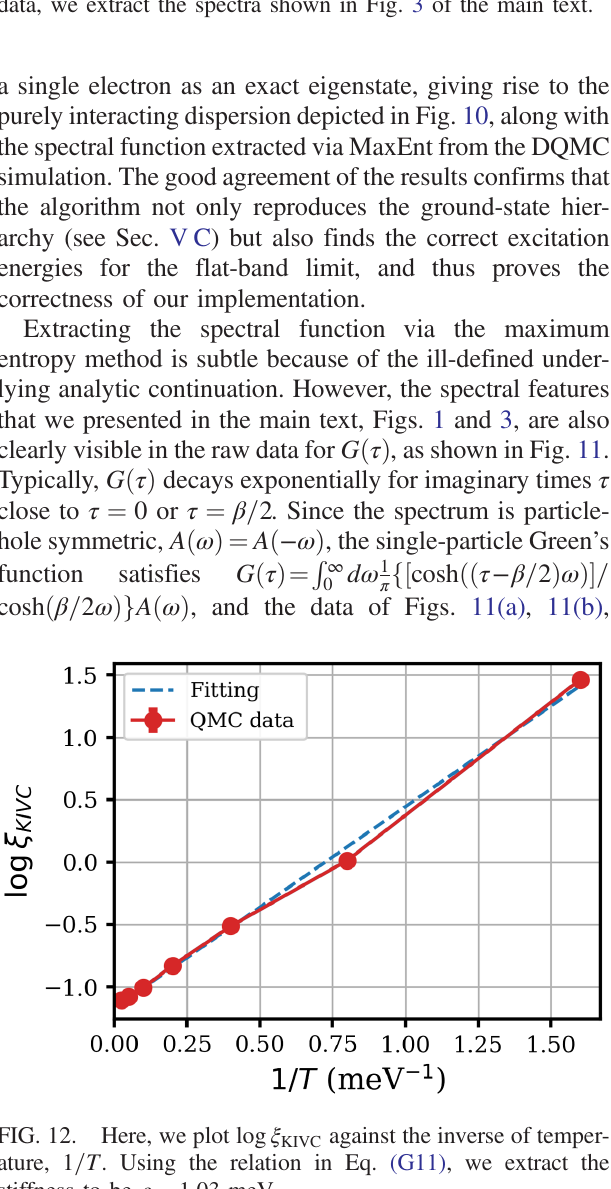
FIG. 11. (a – d) Green ’ s function raw data for different values of κ and momentum k . Using the maximum entropy method on this data, we extract the spectra shown in Fig. 3 of the main text.